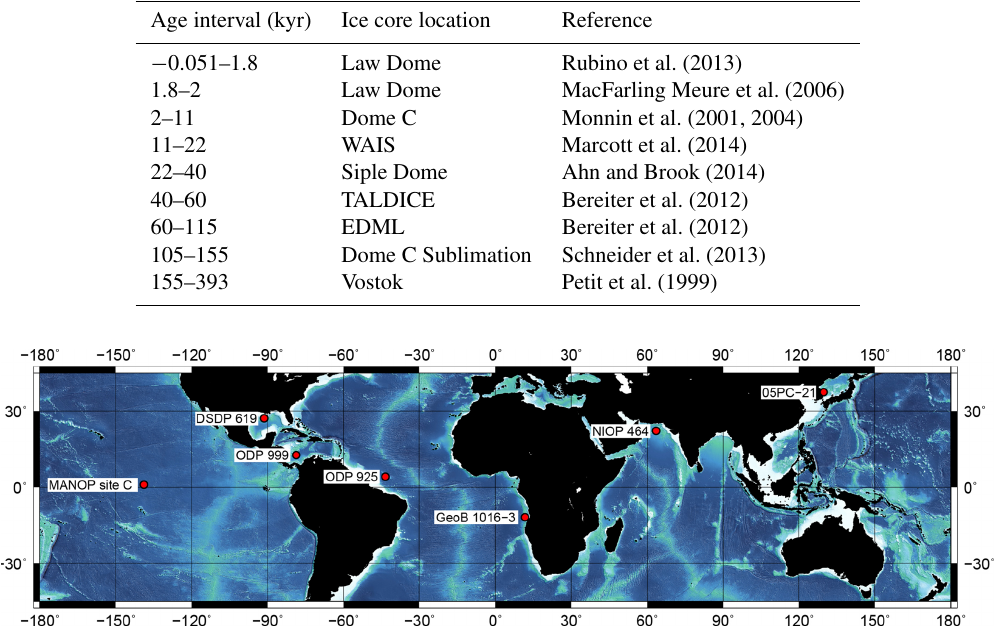
Table 1. Sources of ice core data used throughout, as compiled by Bereiter et al. (2015).